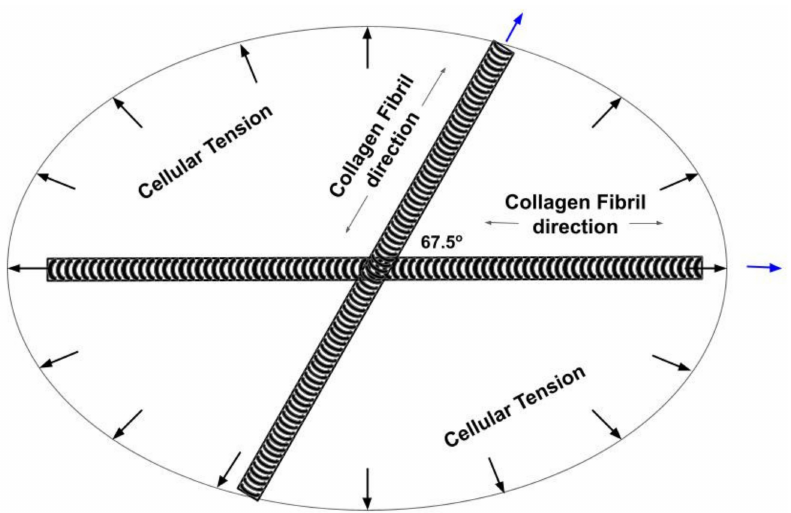
Figure 8. Diagram of the collagen fiber orientation determined from VOCT measurements made on living skin under an applied strain of 5%. When stretched, the collagen fibers attempt to align with the load direction while the cellular tension provides a force to balance the axial fiber forces. When the external load is removed, the cellular tension restores the skin shape by providing a retractile force. Under normal physiologic conditions the collagen fibers are more randomly oriented in the plane of the skin. When the cellular tension is lost, circular defects assume the elliptical orientation determined by the collagen fibers shown in Figure 8.